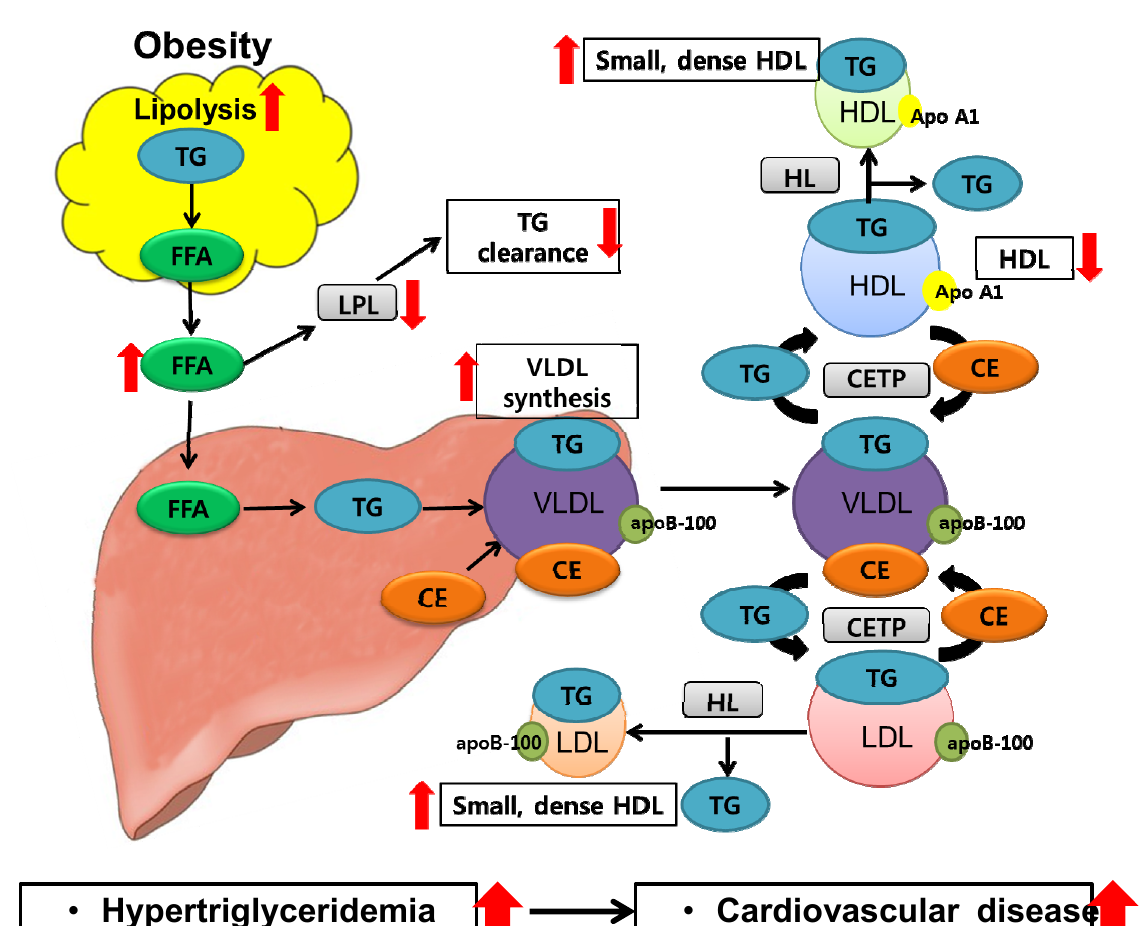
Figure 4. Mechanisms of dyslipidemia in obesity. An increased free fatty acids (FFA) release from adipose tissue via lipolysis can result in enhanced delivery of FFA to the liver. The enhanced FFA leads to increased triglyceride (TG) and very-low-density lipoprotein (VLDL) production in the liver as well as inhibition of lipoprotein lipase in adipose tissue and skeletal muscle, thereby promoting hypertriglyceridemia. Moreover, the increased VLDL in the liver can inhibit lipolysis of chylomicrons, which also contributes to hypertriglyceridemia. The TG in VLDL is exchanged for cholesteryl esters from low-density lipoproteins (LDL) and high-density lipoproteins (HDL) by the cholesteryl ester transport protein, producing TG-rich LDL and HDL. The TG in the LDL and HDL is then hydrolyzed by hepatic lipase, producing both small, dense LDL and HDL. The decreased HDL concentration and formation of small, dense LDL particules are linked to a higher risk of cardiovascular disease. The red arrows indicate increased (when pointing upward) or decreased (when pointing downward) responses to obesity. CE, cholesteryl esters; CETP, cholesteryl ester transport protein; FFA, free fatty acids; HDL, high-density lipoproteins; HL, hepatic lipase; LDL, low-density lipoproteins; LPL, lipoprotein lipase; TG, triglyceride; VLDL, very-low-density